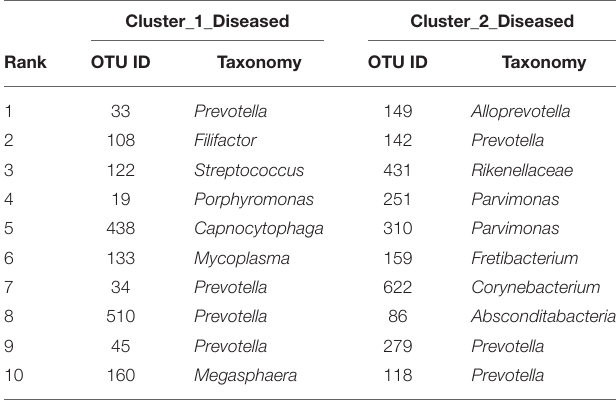
TABLE 2 | The top 10 OTUs with most correlations in the OP bacterial networks of the two clustered OP microbiotas of H7N9 patients.